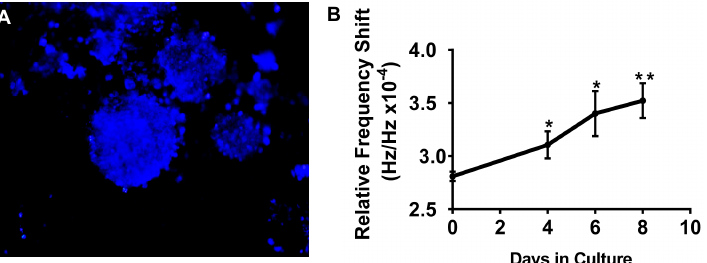
Figure 7. ( A ) Representative image of A549 cells growing in 3D tumoroid structures on the 3P scaffold using NucBlue nuclear stain on Day 8 of culture. ( B ) A549 cells were cultured on the 3P scaffold for eight days. On Days 0 (scaffold with no cells), 4, 6, and 8 scaffolds were collected and transferred to the SAW device with ZnO layer for measurement. Data is plotted as mean ± standard error of the mean. The data is a representative of a study that was performed in triplicates. * = significant increase from Day 0; ** = significant increase from Day 4 ( p ≤ 0.05).